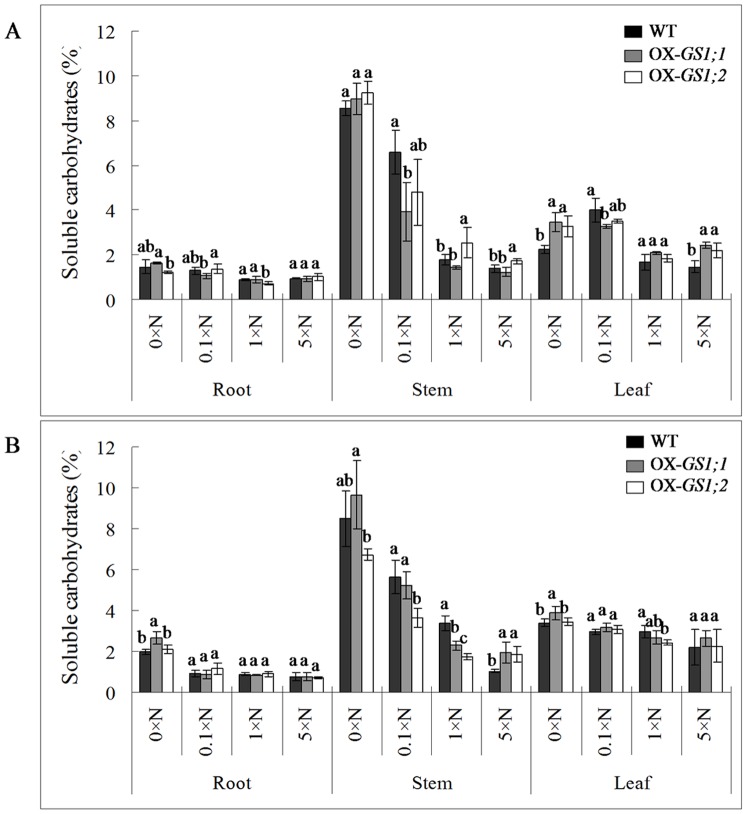
The concentration of soluble carbohydrates in the roots, stems and leaves of the GS1;1-, GS1;2-overexpressing plants (OX-GS1;1, OX-GS1;2) and wildtype plants (WT) at the tillering stage (A) and the heading stage (B) under 0×N, 0.1×N, 1×N and 5×N conditions.Values are the mean ± SD from three biological replications using three randomly mixed plant materials. a, b, c indicate the significant difference at the level of P = 0.05.